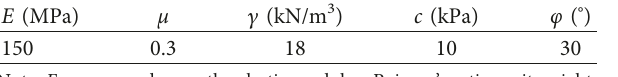
prestressed rebar; 3 (cid:31) Table 1: Soil parameters applied in FE